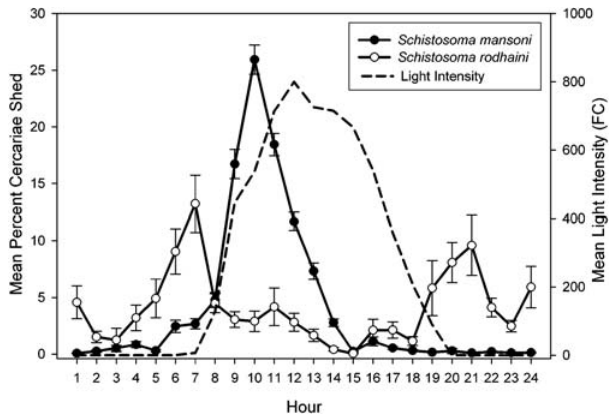
Figure 4. Circadian emergence of Schistosoma mansoni and Schistosoma rodhaini cercariae from naturally infected snails from the Lake Victoria region of Kenya. The mean and standard error are given based on 226 emergence profiles of S. mansoni and 27 for S. rodhaini . Light intensity is represented by the mean of all trials. Time units are hourly units beginning with 0:00–1:00 hours.